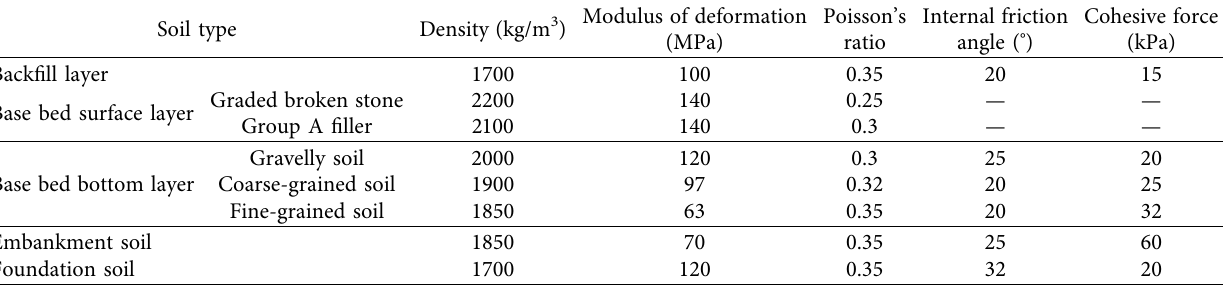
Figure 6: Geometric parameters of the maglev subgrade used in the FEM. Table 1: Material properties considered in the FEM of the maglev subgrade.